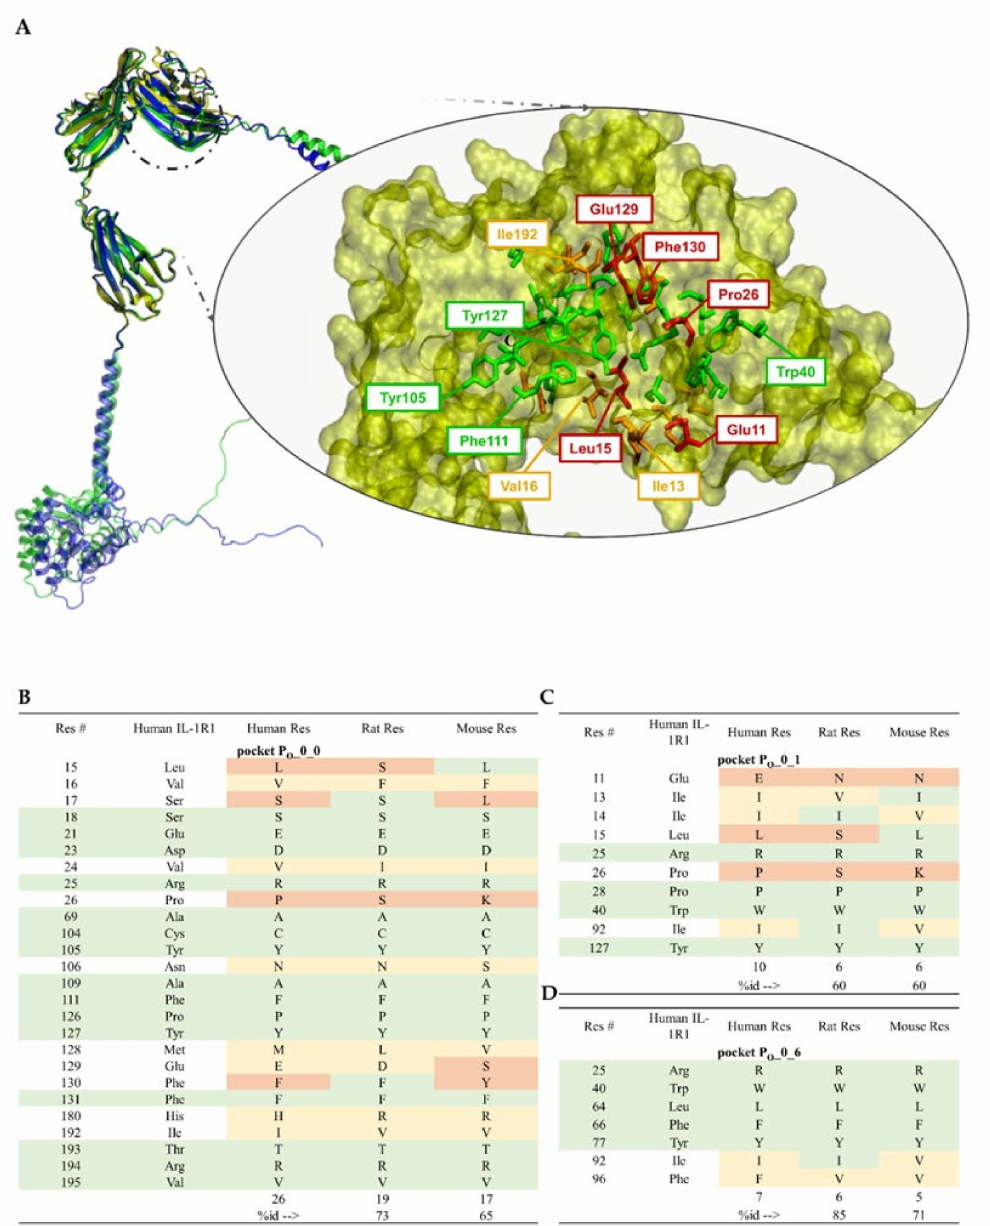
Figure 7. Comparison of human, rat and mouse interleukin-1 receptor type 1 (IL-1R1) protein se- quences and structure. Upper panel: ( A ) Structural alignment of predicted rat (rIL-1R1, colored in green) and mouse (mIL-1R1, colored in blue) structures (full-length) retrieved from the AlphaFold Pro- tein Structure Database [201] with the crystallographic structure of the extracellular domain of human IL-1R1 (hIL-1R1, colored in yellow) (PDB entry 4GAF). The protein structures were superimposed using the MatchMaker tool of the UCSF Chimera 1.15 software program [202]. The D1-D2 surface representation enclosed by the black circle is magnified, along with the conserved and non-conserved residues for the largest pocket (P O _0) predicted by DogSiteScorer. Lower panel: Protein sequence alignment for residues (one-letter code) comprising three “druggable” binding pockets—P O _0_0 ( B ), P O _0_1 ( C ) and P O _0_6 ( D ) predicted in the crystal structure of hIL-1R1 by DoGSiteScorer [200]. The sequence alignment was produced using the Clustal Omega Server [192]. Conservation across orthologs is color-coded as green, for full conservation across the three orthologs (a whole green table line represents 100% conservation); yellow represents amino acid differences with similar side-chain properties; red represents amino acid differences with distinct side-chain